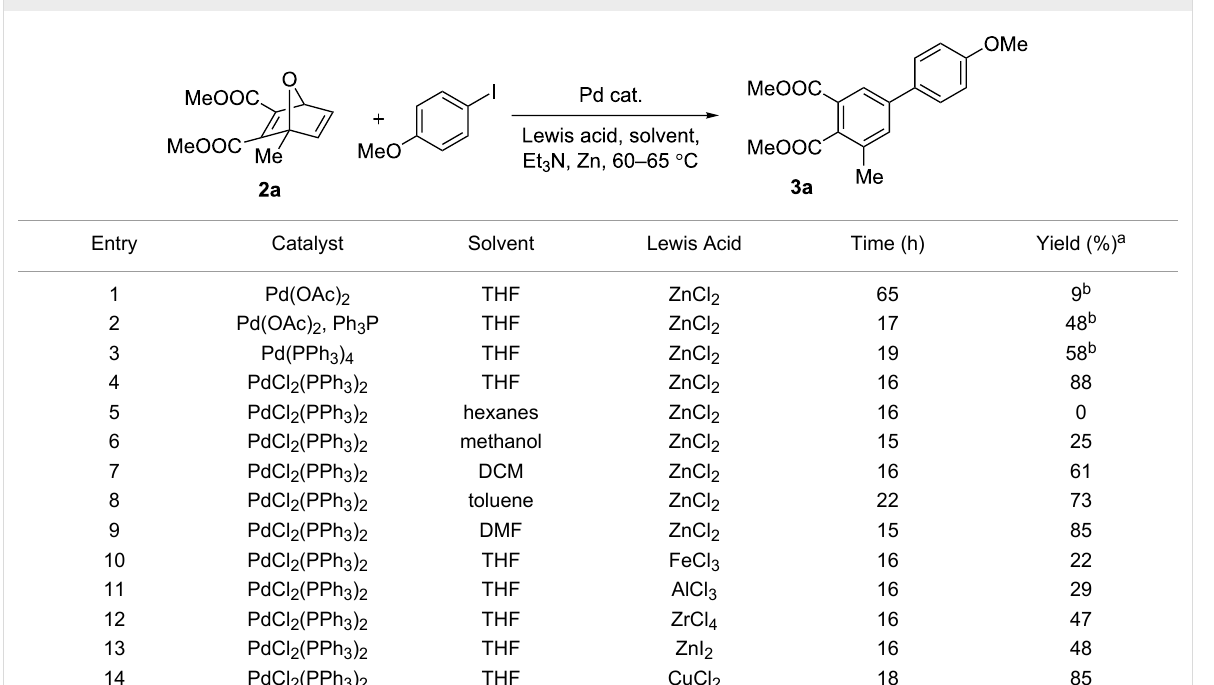
Table 1: Optimization of palladium catalyst, Lewis acid additive, and